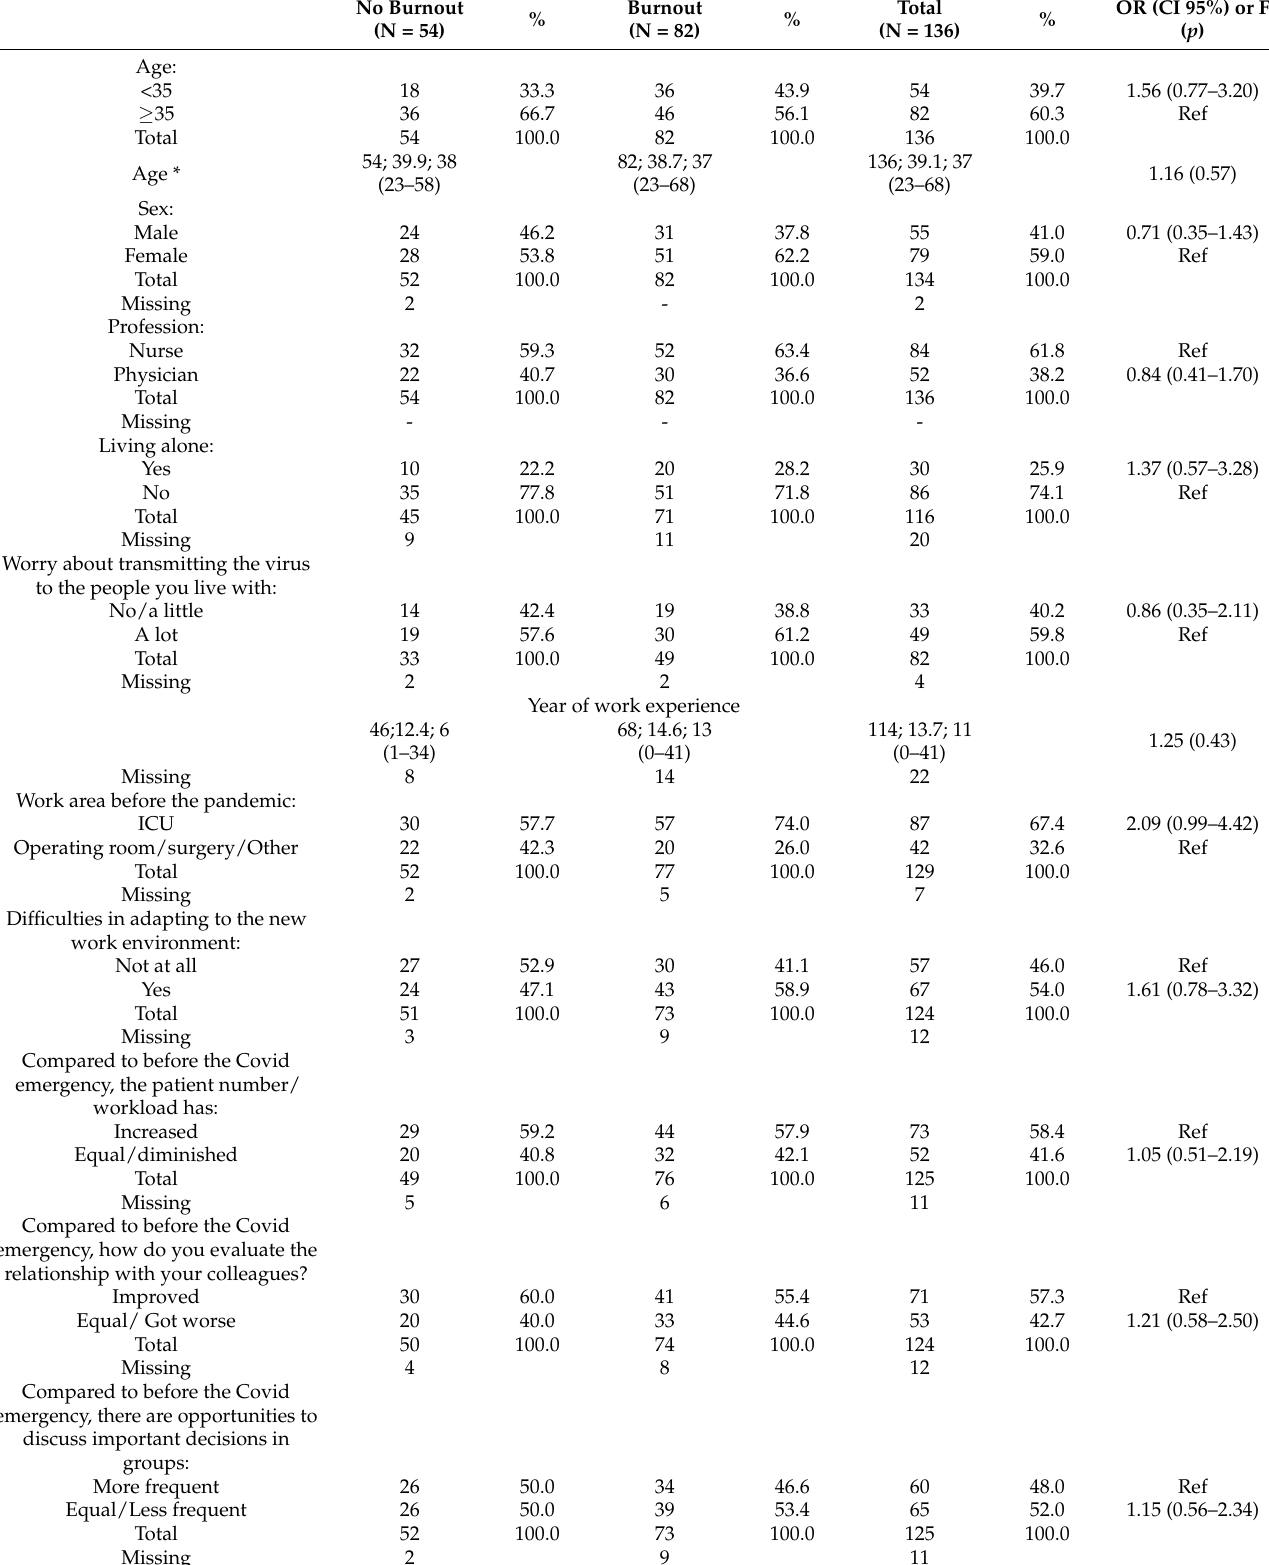
Table A2. Demographic indicators by prevalence of burnout (Reference = No